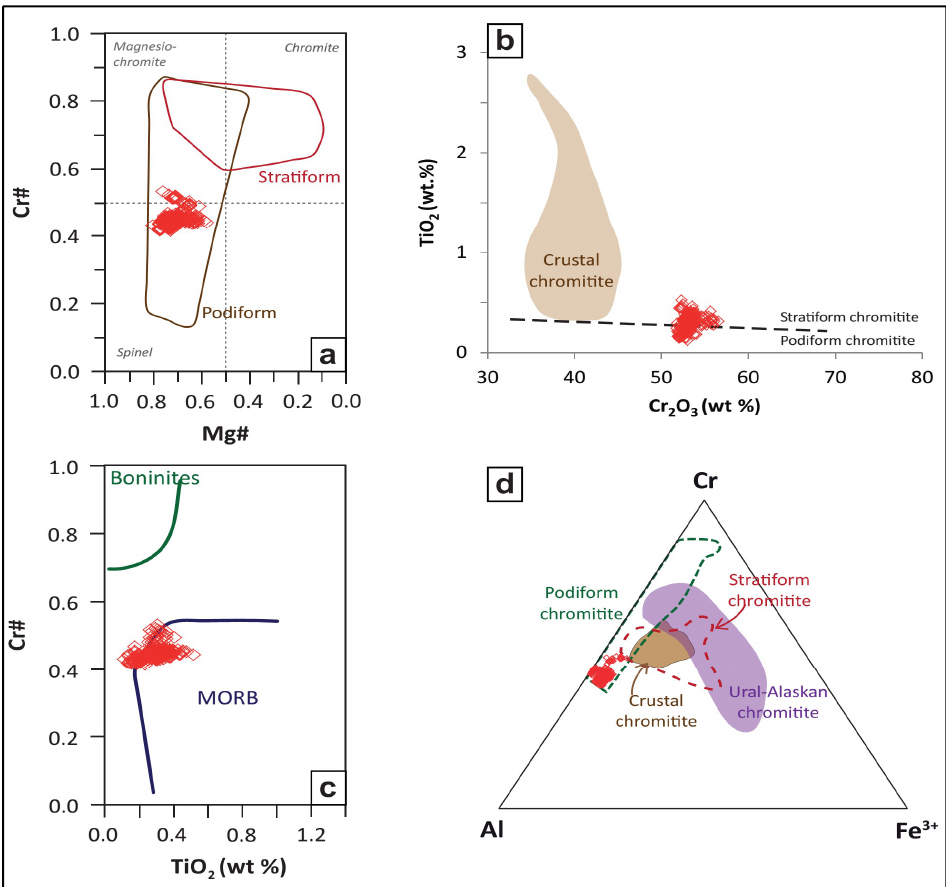
Figure 3. Mercedita chromite composition diagrams: ( a ) Cr# [Cr/(Cr + Al)] versus Mg# [Mg/(Mg + Al)]; ( b ) TiO 2 versus Cr 2 O 3 (wt %) diagram showing the compositional fields for podiform, stratiform and crustal chromite; ( c ) Cr# versus TiO 2 (wt %) showing the type of melt in equilibrium; ( d ) Fe 3+ –Cr–Al ternary diagram showing the fields for different types of chromitites. Compositional fields are after [51,52] in ( a ), after [53,54] in ( b ), ( d ) and after [55] in ( c ).